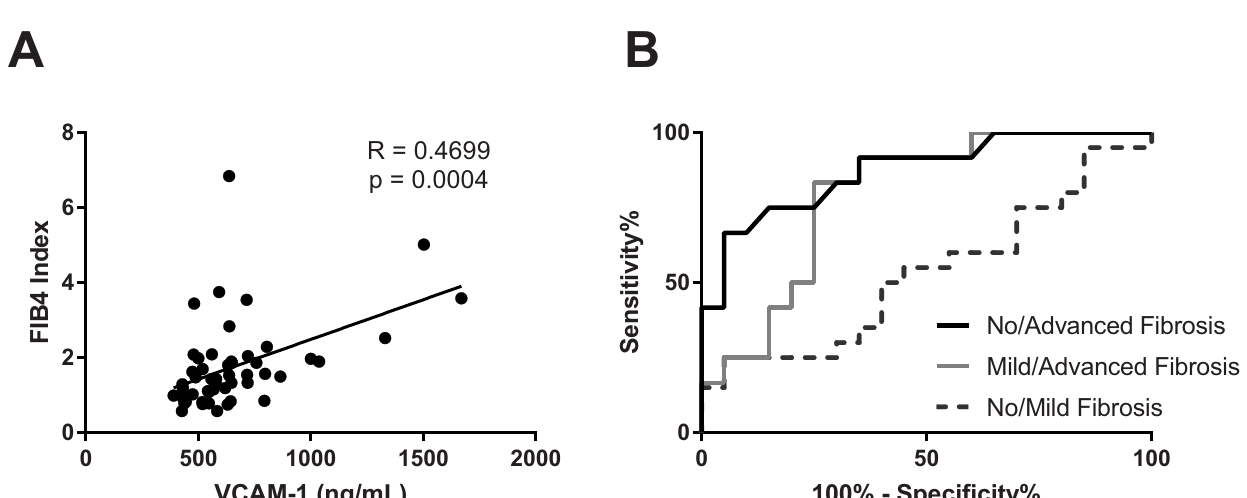
Fig 4. VCAM-1 demonstrates good performance in distinguishing advanced fibrosis in NASH. (A) VCAM-1 correlates with FIB4 values. (B) ROC curves demonstrating performance of VCAM-1 to distinguish fibrosis severity in NASH. AUROC of 0.87, 0.79, 0.53 for no/advanced, mild/advanced, and no/mild fibrosis severity